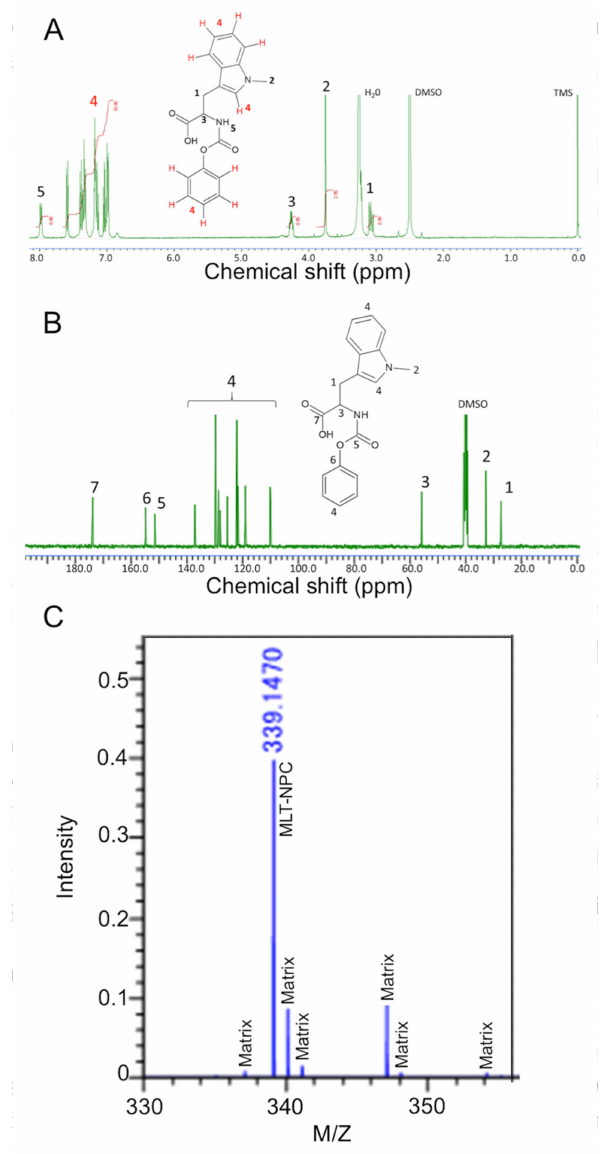
Figure 3. ( A ) 1 H-NMR spectra of MLT-NPC in DMSO-d 6 . ( B ) 13 C-NMR spectra of MLT-NPC in DMSO-d 6 . ( C ) MALDI-TOF of